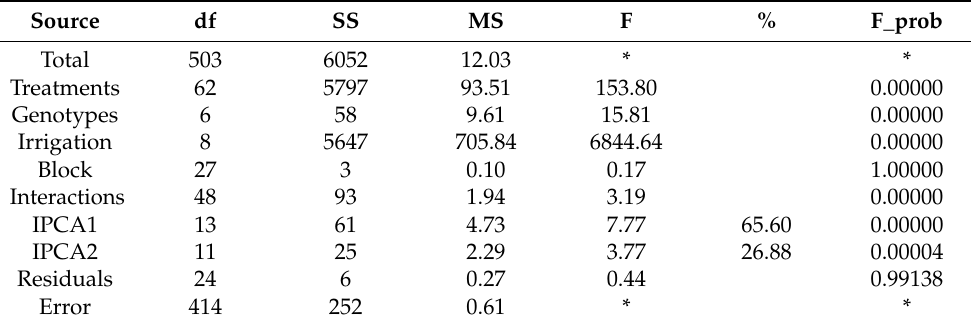
Table 4. AMMI analysis parameters in different irrigation with different maize hybrids.